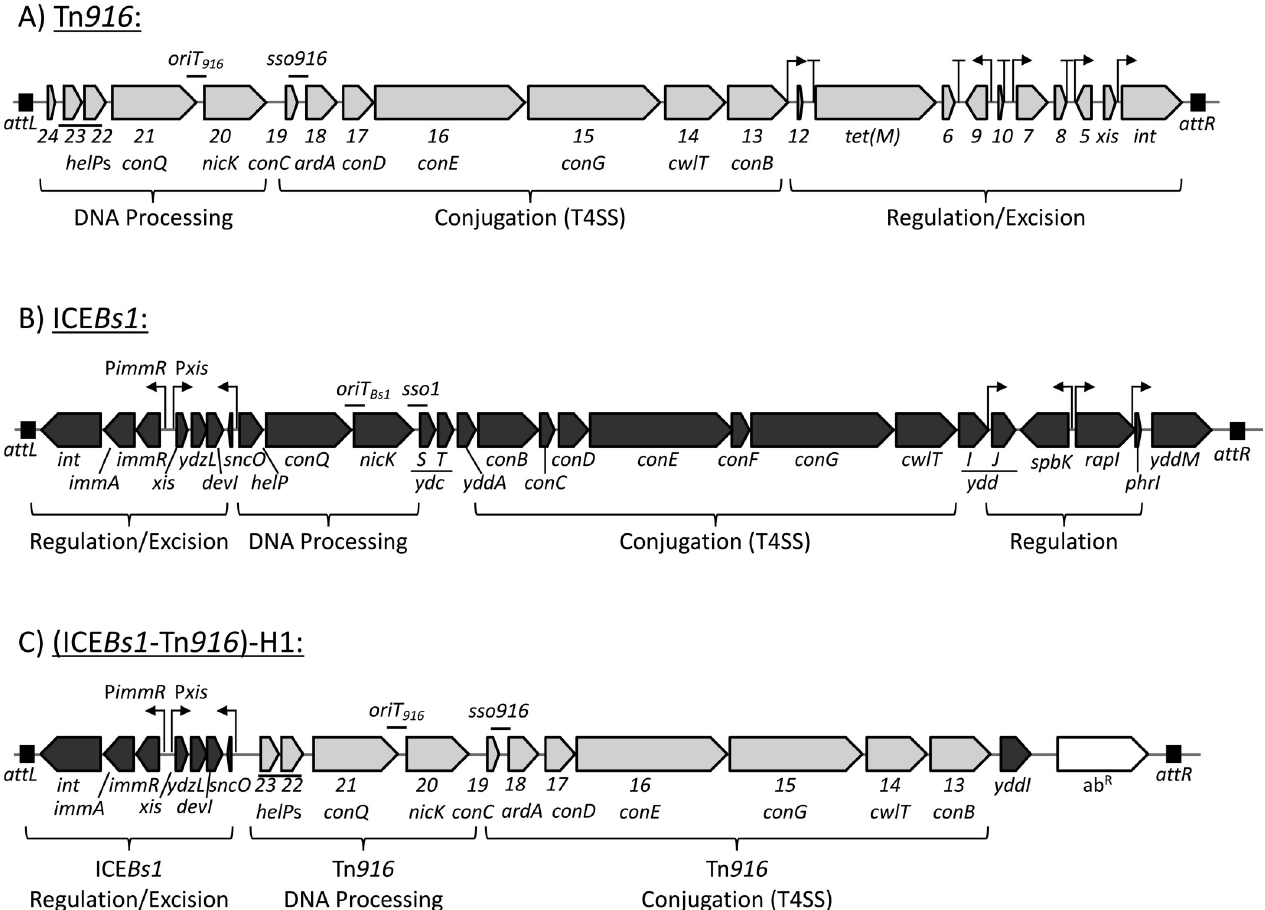
Fig 1. Genetic maps of Tn 916 , ICE Bs1 , and (ICE Bs1 -Tn 916 )-H1. Maps of the conjugative elements used in these studies are shown: A) Tn 916 , B) ICE Bs1 , and C) (ICE Bs1 -Tn 916 )-H1 (or ICE-H1, for short). Open reading frames are indicated by horizontal boxes with arrows at the end (gray for Tn 916 , black for ICE Bs1 ). Tn 916 gene names are abbreviated to include only the number designation from the name (i.e., “ orf23” is written as “ 23 ”), and, when appropriate, the homologous ICE Bs1 gene is written below. ICE-H1 contains a combination of Tn 916 and ICE Bs1 genes, as previously described [41]. Functional modules are indicated by brackets below each map. Black boxes indicate attachment sites attL and attR at the ends of each element. In B . subtilis , Tn 916 is integrated between yufK and yufL , unless otherwise indicated. ICE Bs1 and ICE-H1 are integrated at trnS - leu2 . Some of the promoters are indicated by bent arrows and some transcription terminators (in Tn 916 ) are indicated by “T” shapes. ICE-H1- Δ attR Δ orf20 {ICE-H1- Δ attR (Rep-)} is essentially the same as ICE-H1 (panel C) with a deletion of attR (right end, from ICE Bs1 ) and orf20 (encoding the relaxase needed for nicking at oriT , conjugative transfer, and autonomous rolling circle replication). Previously determined origins of transfer ( oriT ) and single strand origins of replication ( sso ) are indicated by a “-”above the genetic map [32,84,92,93]. To induce activation of ICE Bs1 and ICE-H1 and their derivatives, the activator RapI was overproduced from Pxyl- rapI (located at an ectopic locus on the chromosome; see Table 2). Active RapI causes the anti-repressor and protease ImmA to cleave the ICE Bs1 repressor ImmR, thereby causing derepression of transcription from the promoter Pxis [42,43,83].This figure is adapted from